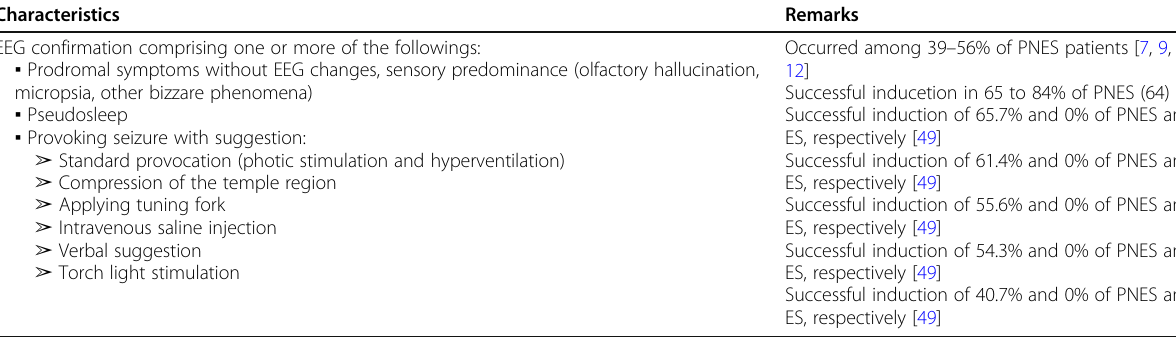
Table 2 EEG characteristics of PNES patients